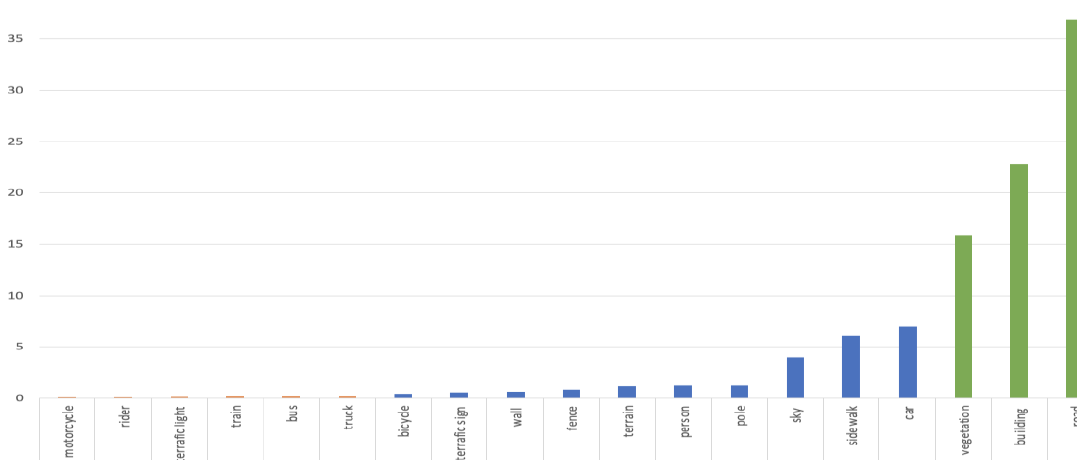
Figure 1. The class distribution of the cityscape